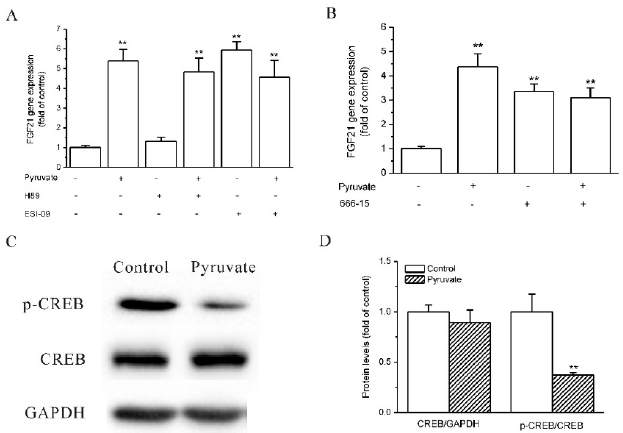
Figure 4. Epac and CREB were involved in pyruvate-stimulated FGF21 expression in HepG2 cells. ( A ): Epac inhibitor ESI-09 but not PKA inhibitor H89 upregulated FGF21 expression and eliminated the stimulatory effect of pyruvate on FGF21 expression (** p < 0.01 vs. control, n = 3) ( B ): CREB inhibitor 666-15 upregulated FGF21 expression and eliminated the stimulatory effect of pyruvate on FGF21 expression (** p < 0.01 vs. control, n = 3). ( C , D ): Pyruvate reduced CREB phosphorylation without influencing the total CREB protein levels (** p < 0.01 vs. control, n = 3).